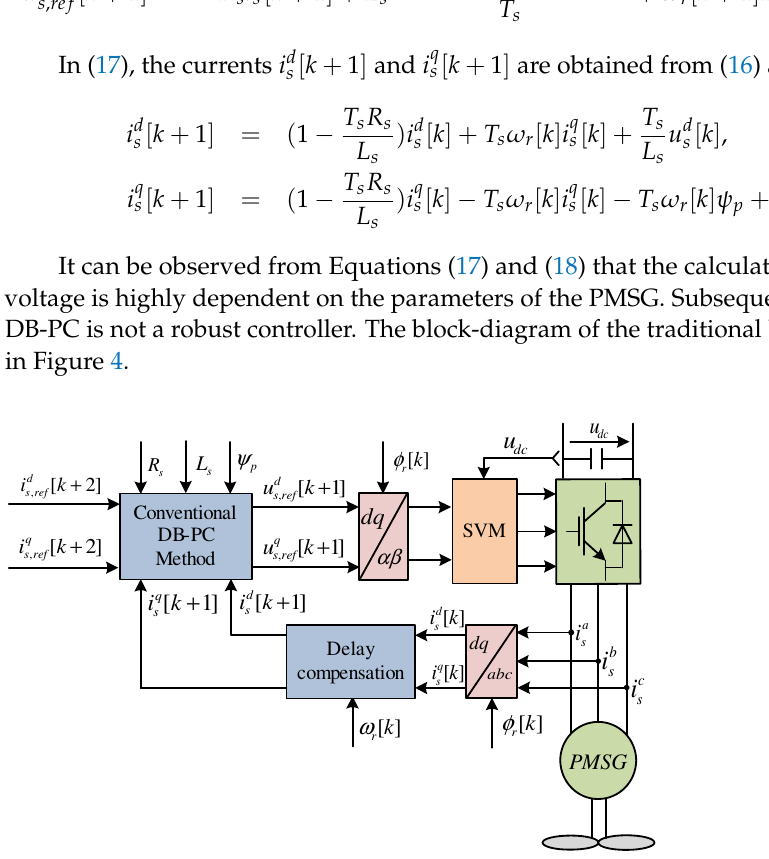
Figure 4. Traditional deadbeat predictive control technique for